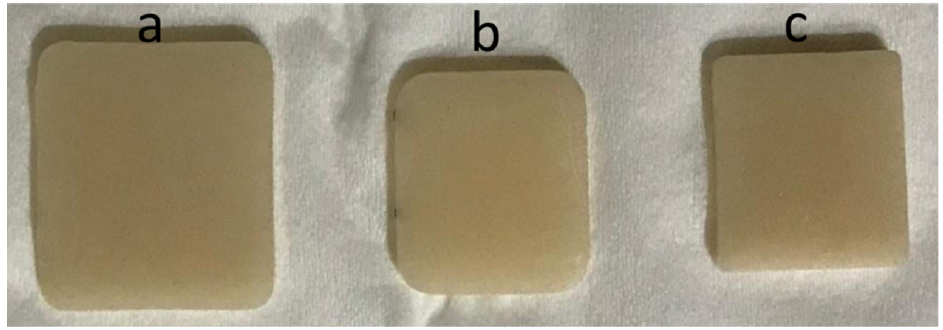
Figure 1. The finished and polished ceramic samples; ( a ) IPS e.max CAD, ( b ) Celtra Duo CAD, and ( c ) VITA ENAMIC.